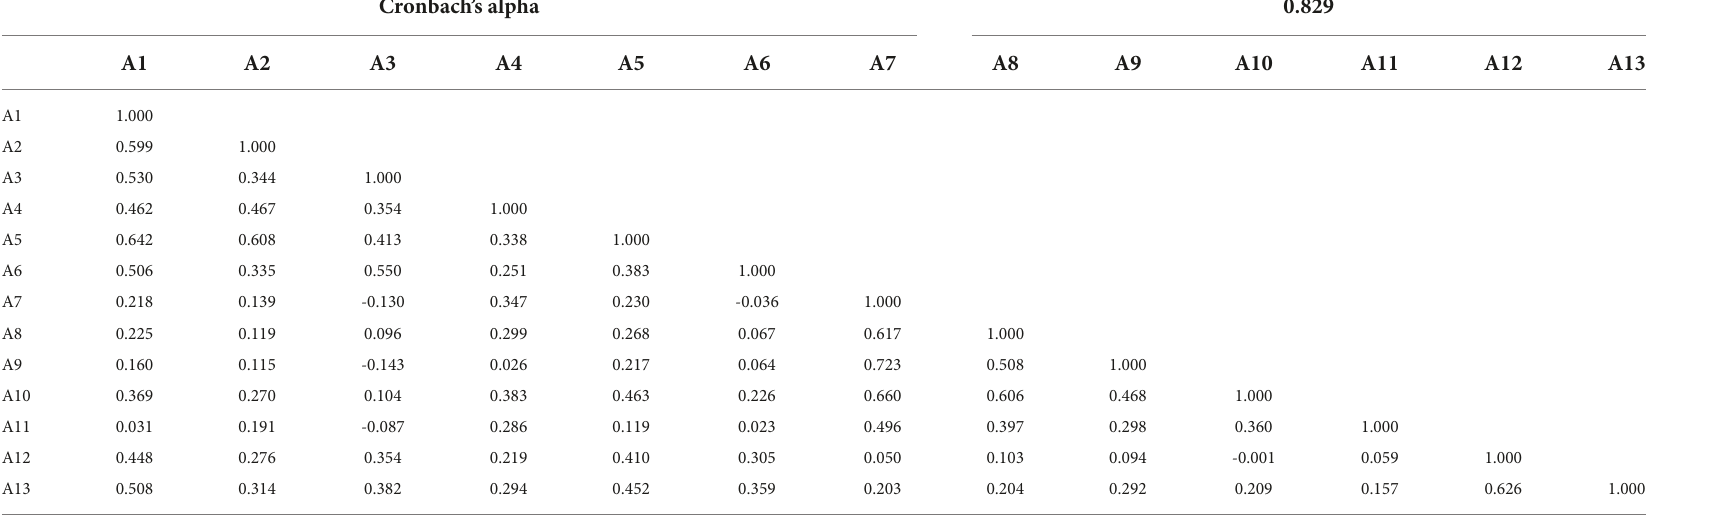
TABLE 8 Results of the reliability (internal consistency) analysis in the attitude section of the validation